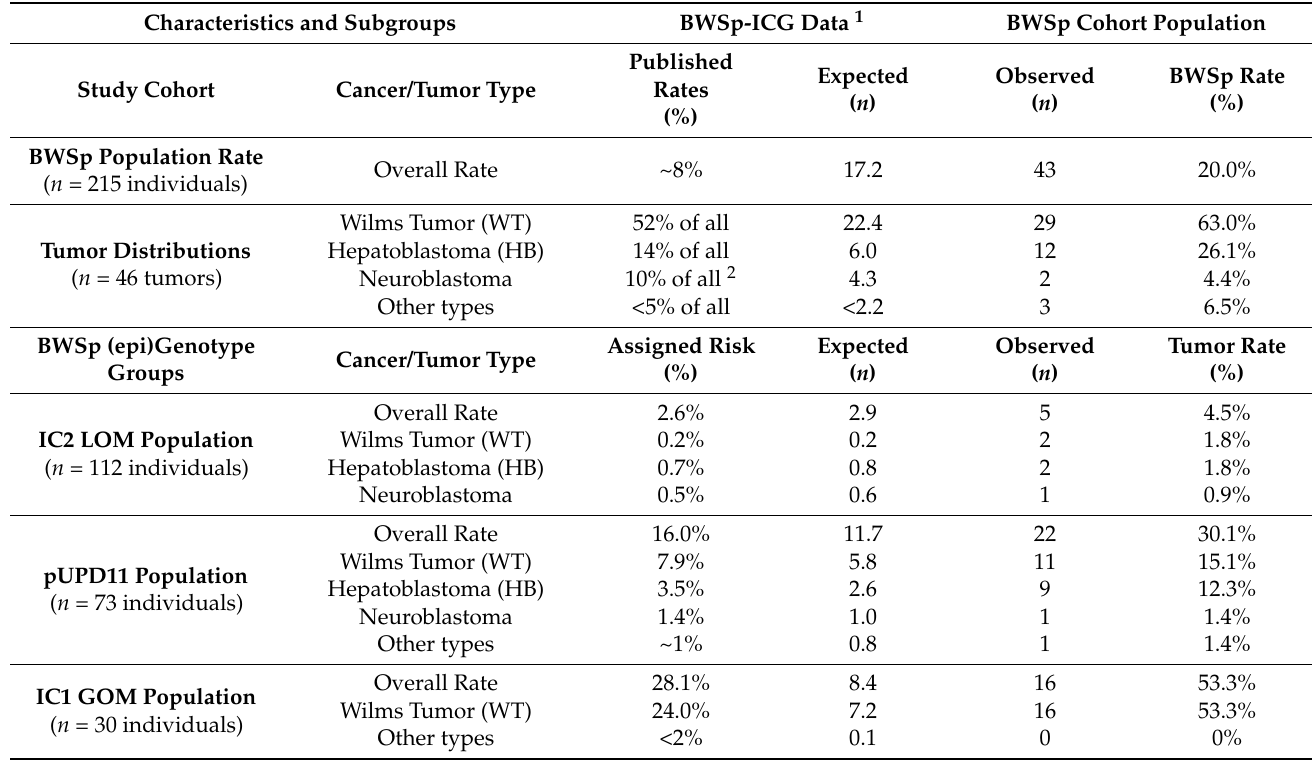
Table 1. Frequency of expected and observed rates of cancer types that developed within BWSp study cohort population. Characteristics and